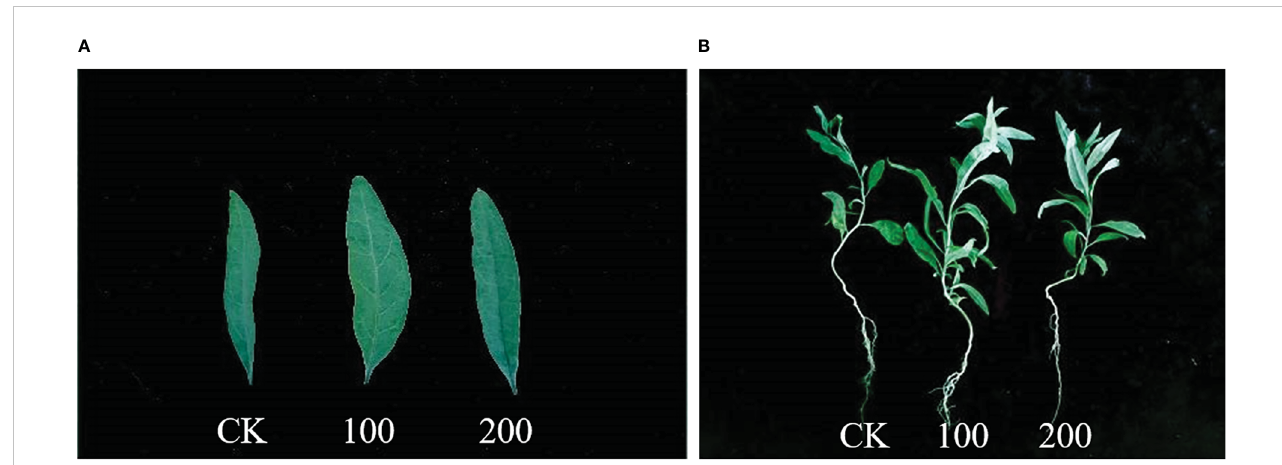
FIGURE 1 Phenotype of seedlings treated with different concentrations of salt for 7 days. (A) Leaf blade phenotype. (B) Whole plant phenotype. CK, 0 mmol·L − 1 . 100, 100 mmol·L − 1 . 200, 200 mmol·L − 1